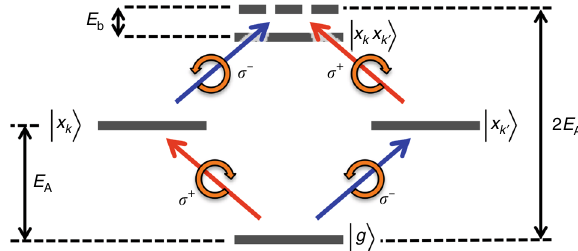
Fig. 2 Intervalley biexciton formation from sequential photon absorption. A right-hand ( σ + ) or left-hand ( σ − ) circularly polarized pulse raises the system from the ground state, | g 〉 , to populate either the K - or K ′ -valley with an exciton, | x K 〉 or | x K ′ 〉 respectively. A second photon of opposite chirality can then transition the system from the valley exciton to the intervalley biexciton state via the process j x K 0 i ! j x K 0 x K i or j x K i ! j x K x K 0 i . This bound intervalley biexciton is reduced by its binding energy, E b , to below twice the exciton energy, E A .